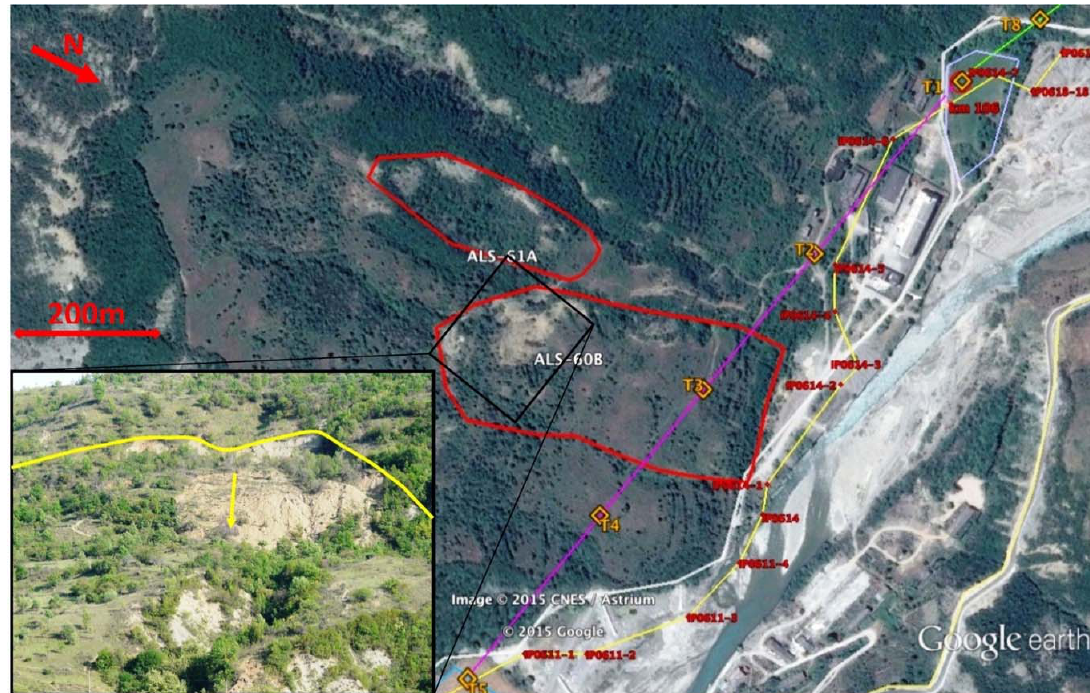
Figure 20. Initially proposed natural gas pipeline route (yellow line) relative to the active landslides ALS-60B (Figure 18) and ALS-61A, and proposed microtunnel (pink axis) solution designed to bypass beneath them, in Corovode area (Albania). The crest of landslide ALS-60B is shown in the inset picture.